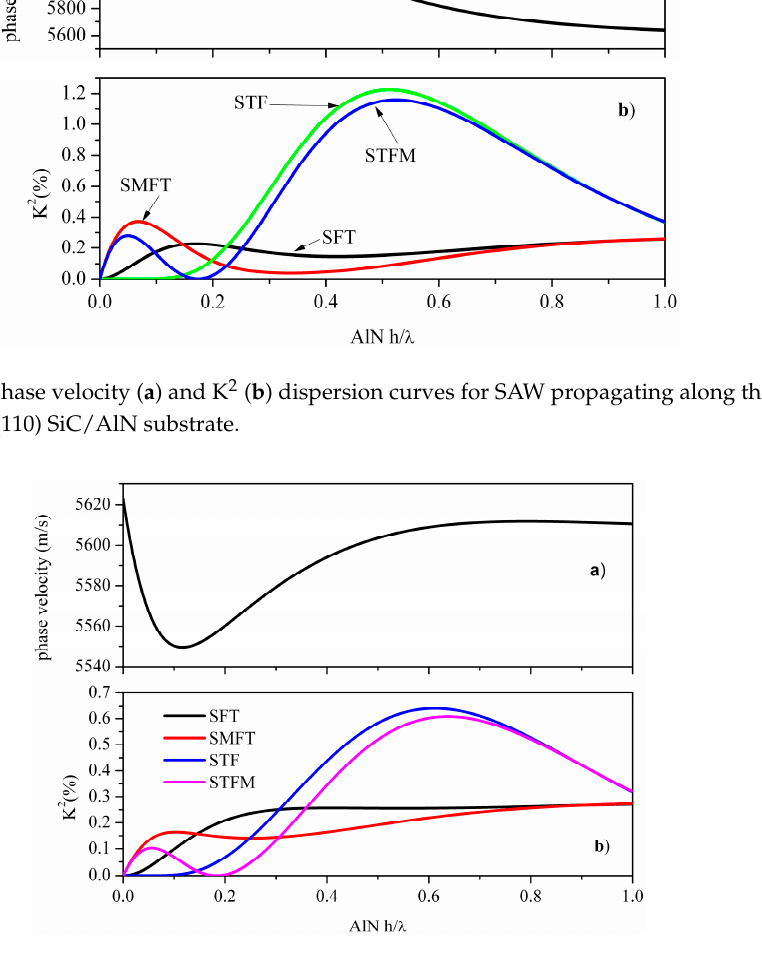
Figure 17. The phase velocity ( a ) and K 2 ( b ) dispersion curves for SAW propagating along the <110> direction of the (110) SiC/AlN substrate.